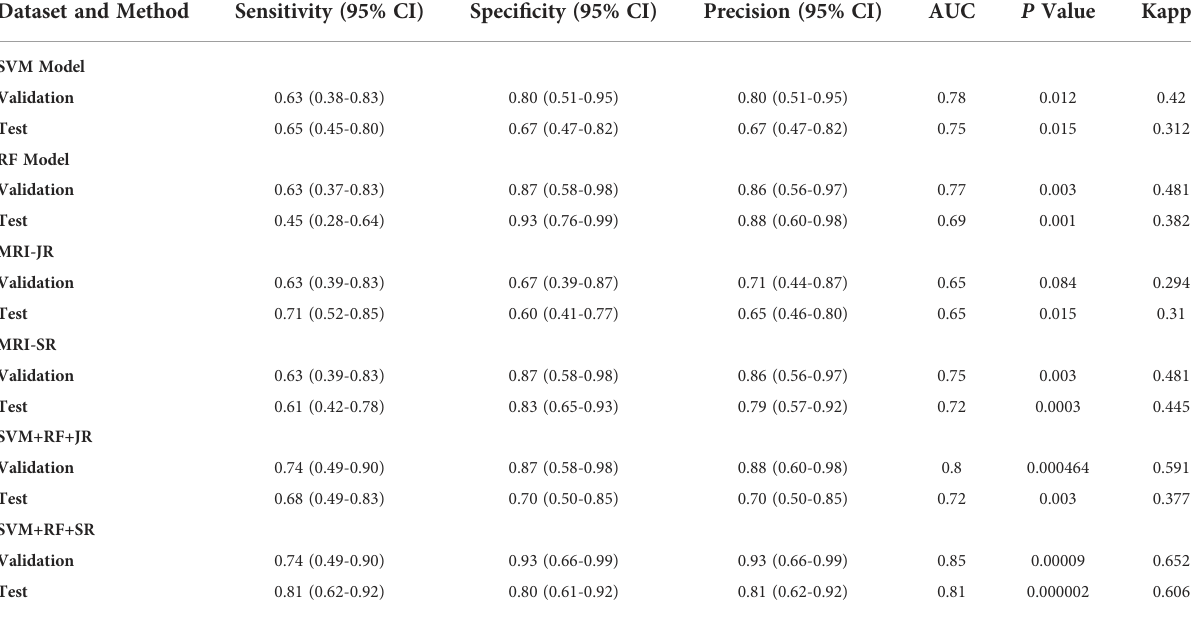
TABLE 3 Diagnostic performance of machine learning model and MRI on a per-lesion basis. Dataset and